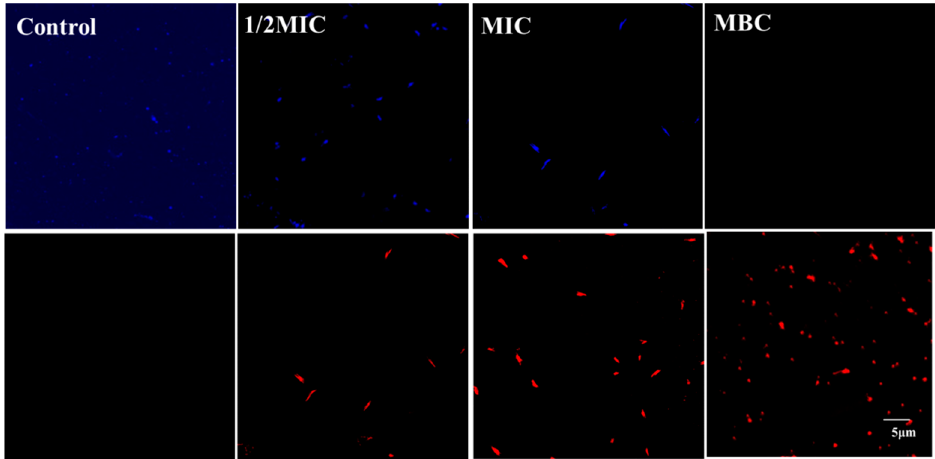
Figure 3. Effect of juglone on cell viability. CLSM (confocal laser scanning microscopy) was used to analyze the viability of P. aeruginosa exposed to different concentrations of juglone.